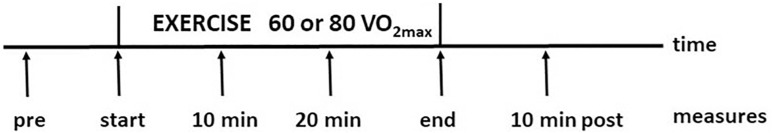
Schematic representation of the experimental protocol. Blood lactate levels were quantified before the exercise (pre), every 10 min during exercise (during), immediately at the end of exercise (end), and finally, 10 min after exercise was completed (post). The Simple Reaction Time, Stroop Color Word Test, and Trial Making Test were measured immediately at the end of the exercise (end) and 10 min after the exercise was completed (post).